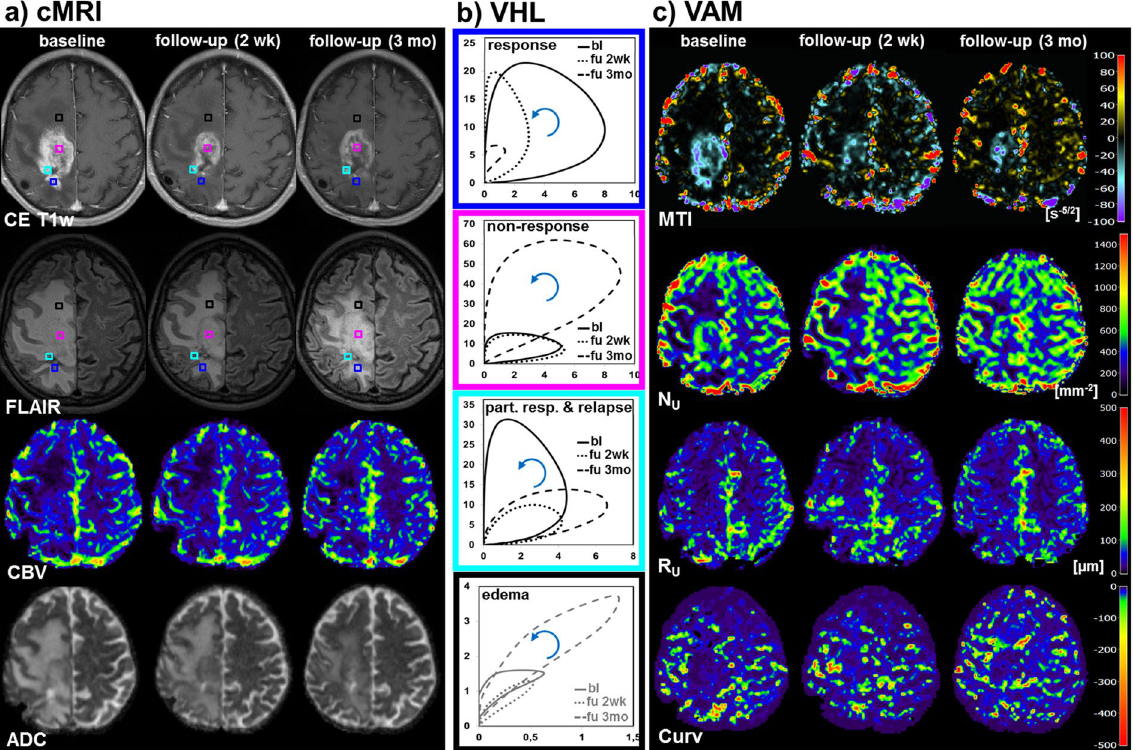
Figure 3. Vascular hysteresis loops and VAM biomarker maps for a 54-year-old male patient suffering from a recurrent glioblastoma before AAT onset (baseline, bl), at early 2-week follow-up (“fu 2wk”), and at 3-month follow-up (“fu 3mo”). ( a ) Conventional MRI (cMRI) included contrast-enhanced T1-weighted (CE T1w), FLAIR, GE-EPI DSC perfusion evaluated as maps of cerebral blood flow (CBV), and DWI evaluated as apparent diffusion coefficient (ADC), respectively. ( b ) VHLs, i.e. the ∆ R (y-axis) versus ∆ R 2,SE3/2 (x-axis) diagrams, for 2,GE a voxel position in the responding (blue-framed VHLs), non-responding (magenta), partial responding tumor with relapse (cyan), and for edema in the vicinity of the non-responding tumor (black). The voxel positions are marked with squares in the CE T1w and FLAIR images in ( a ) and have the same color as the frames of the VHLs. The arrows indicate the rotational direction of the VHLs. ( c ) The maps of the microvessel type indicator (MTI), the upper limit for microvessel density (N U ) and radius (R U ) adapted to the temporal shift phenomenon, and the curvature (Curv) of the VHL (top-down). The color codes are depicted at the right image